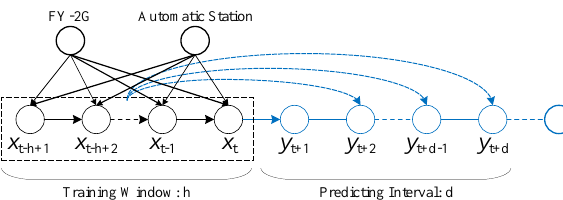
Figure 2. Basic idea of precipitation occurrence prediction for